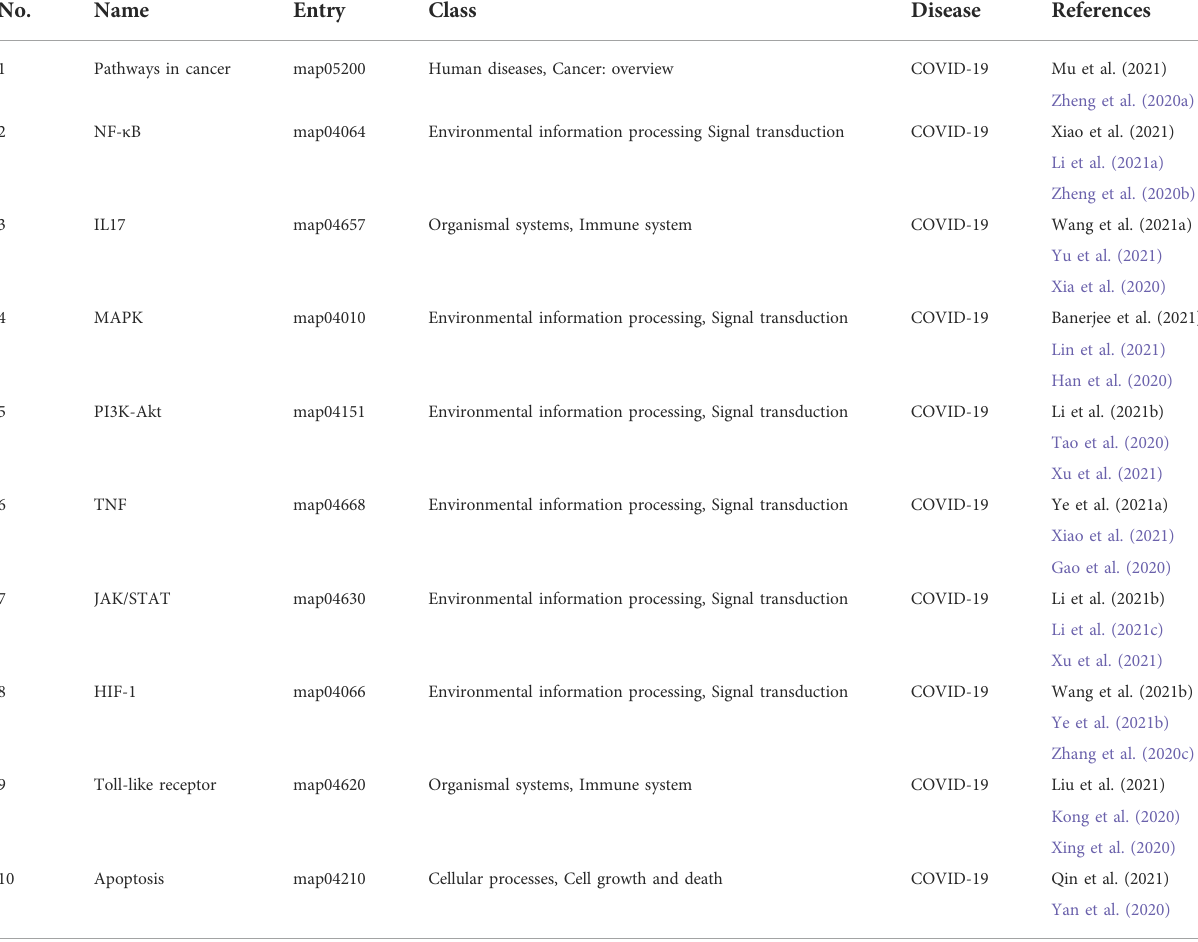
TABLE 2 Key signaling pathways in the treatment of COVID-19.